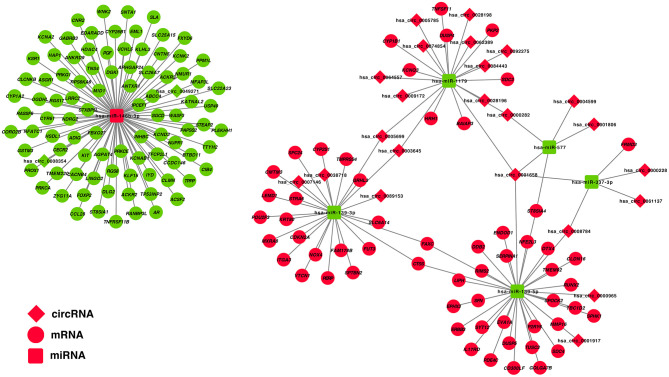
Construction of a circRNA–miRNA–mRNA ceRNA network in the PTC. DE-circRNAs are presented in the diamond nodes, DE-miRNAs are presented in the rounded square nodes, and the DE-mRNAs are presented in the elliptical nodes. Nodes shown in red indicate upregulation in PTC, whereas nodes shown in green indicate downregulation. The circRNA–miRNA–mRNA ceRNA network in PTC includes 25 DE-circRNAs (hsa_circ_0003645, hsa_circ_0089153, hsa_circ_0005699, hsa_circ_0062389, hsa_circ_0028198, hsa_circ_0092275, hsa_circ_0074854, hsa_circ_0028196, hsa_circ_0001658, hsa_circ_0001806, hsa_circ_0007146, hsa_circ_0005785, hsa_circ_0061137, hsa_circ_0009172, hsa_circ_0004599, hsa_circ_0064557, hsa_circ_0038718, hsa_circ_0008784, hsa_circ_0000228, hsa_circ_0000965, hsa_circ_0084443, hsa_circ_0000282, hsa_circ_0001917, hsa_circ_0008354, and hsa_circ_0049271), 6 DE-miRNAs (hsa-miR-146b-3p, hsa-miR-337-3p, hsa-miR-577, hsa-miR-1179, hsa-miR-139-3p, and hsa-miR-139-5p), and 150 DE-mRNAs.